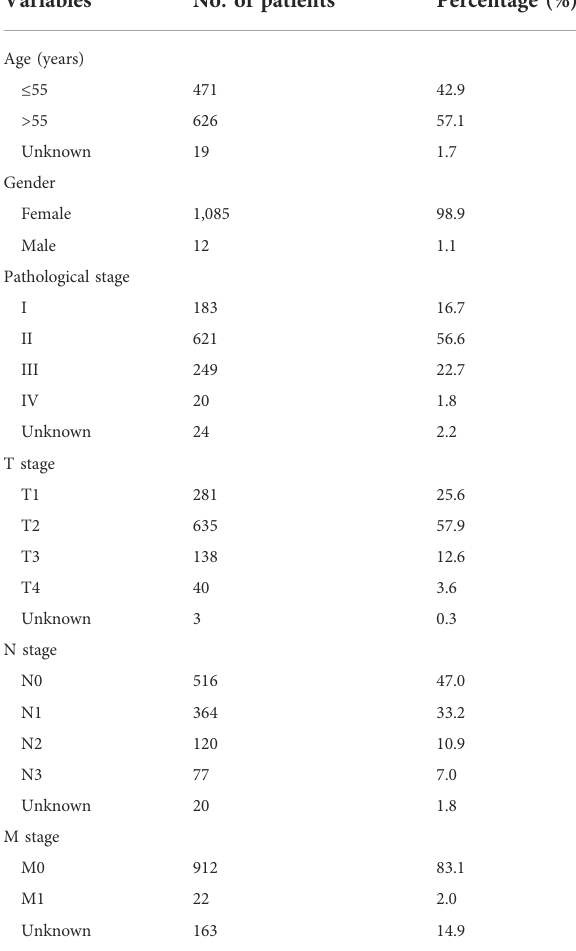
TABLE 1 Clinical characteristics of breast cancer patients in the training cohort.